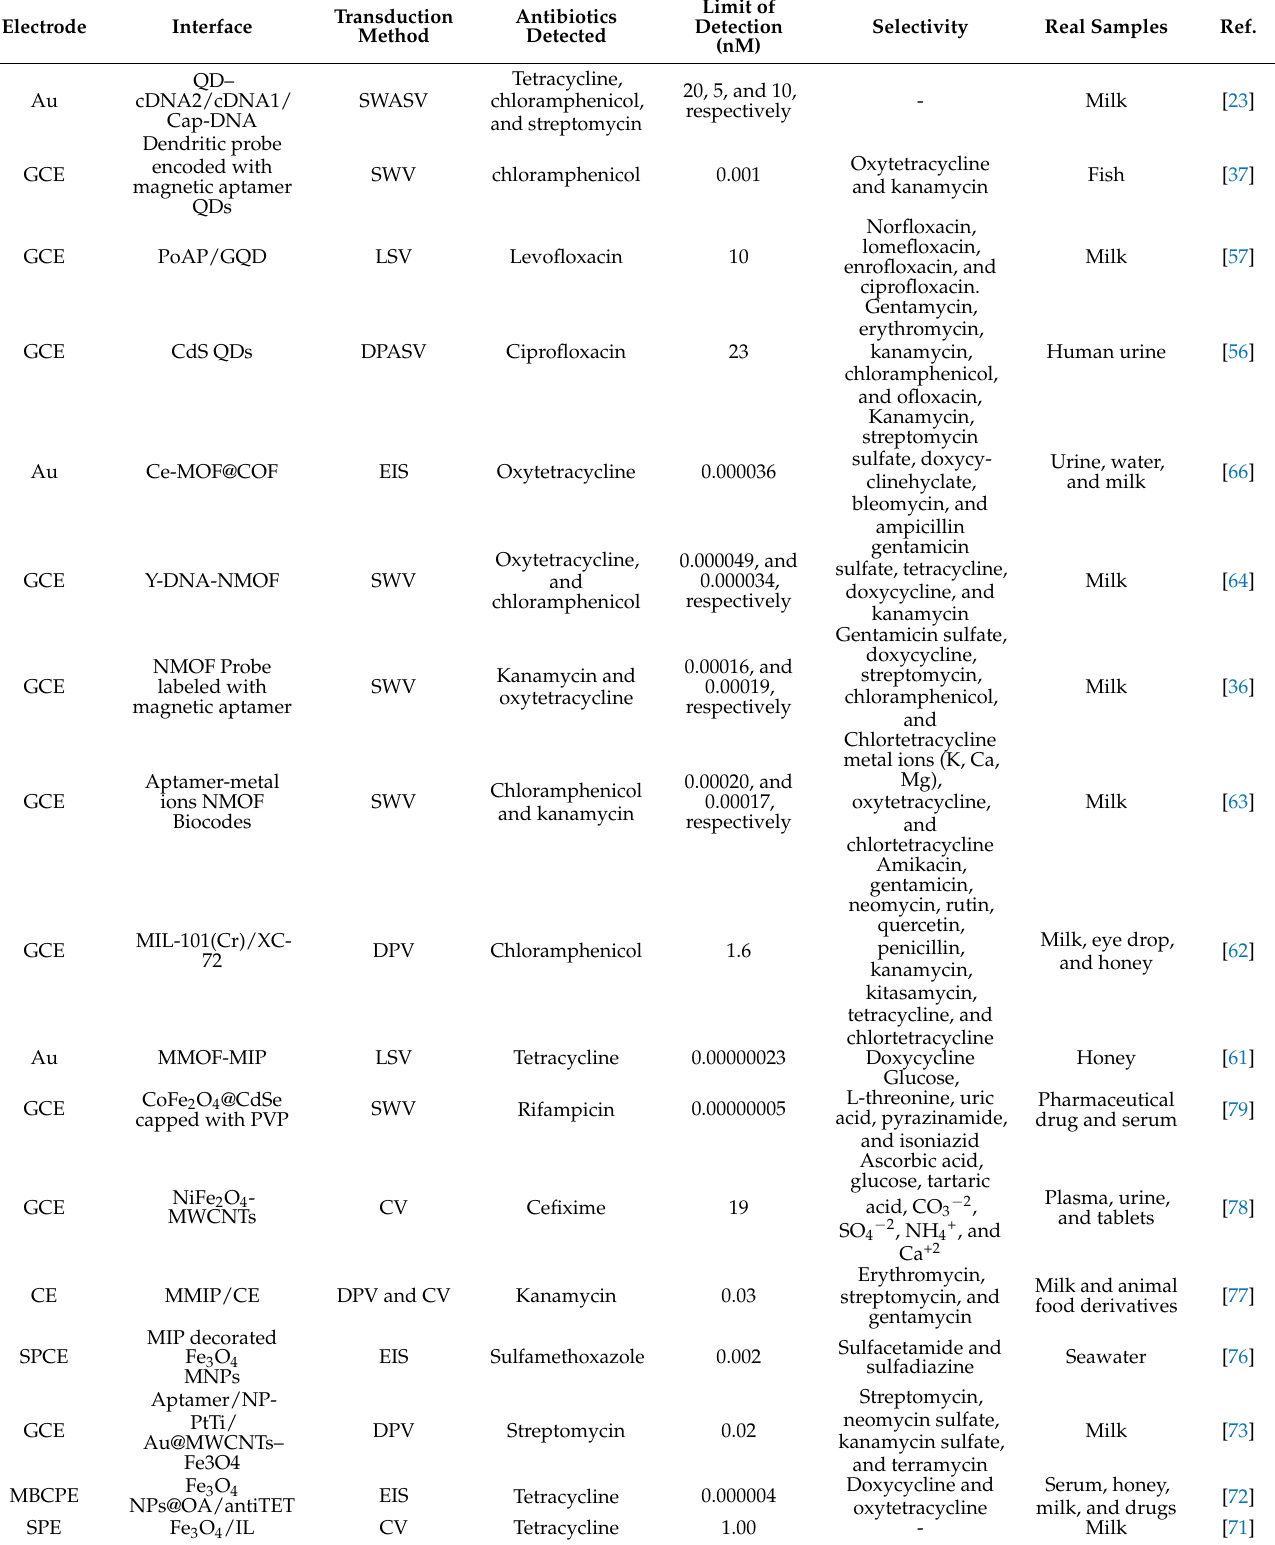
Table 2. Antibiotics electrochemical sensors based on nanomaterials and their